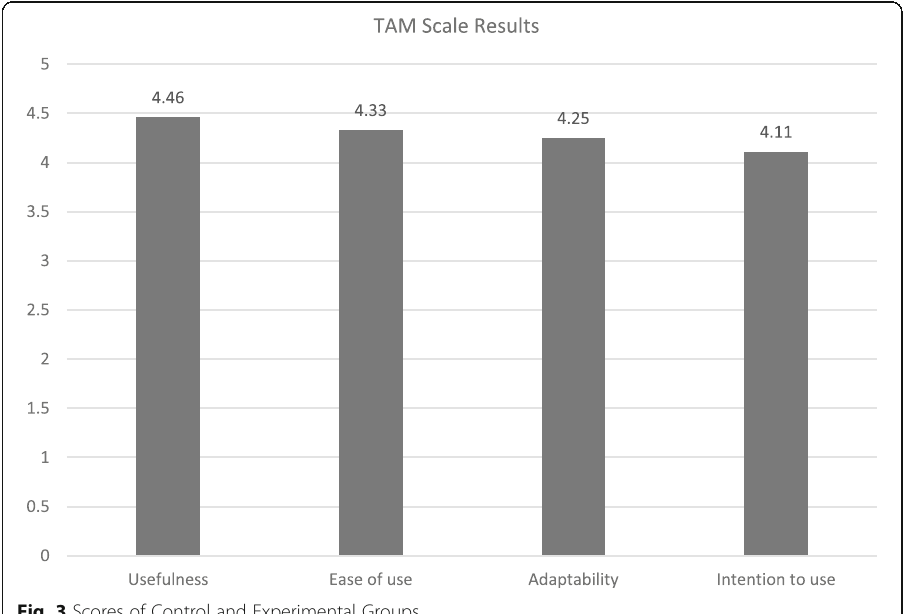
Fig. 3 Scores of Control and Experimental